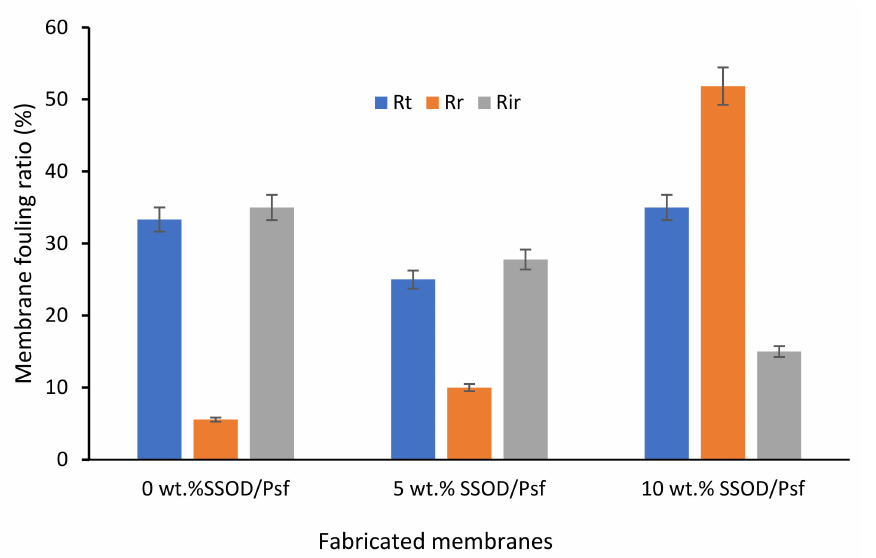
Figure 12. Total fouling ratio (R t ), irreversible ratio (R ir ), and reversible fouling ratio (R r ), of the fabricated membranes during filtration at 4